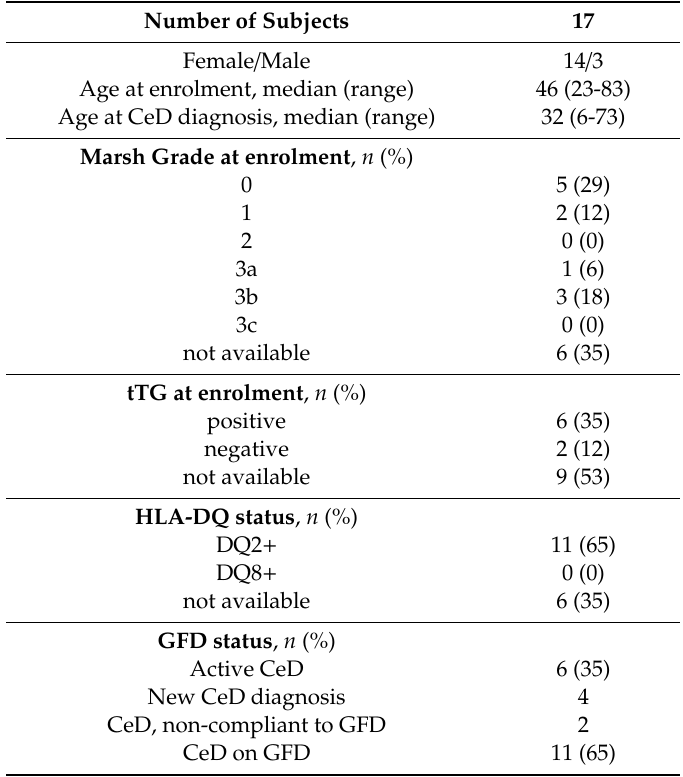
Table 1. Characteristics of CeD